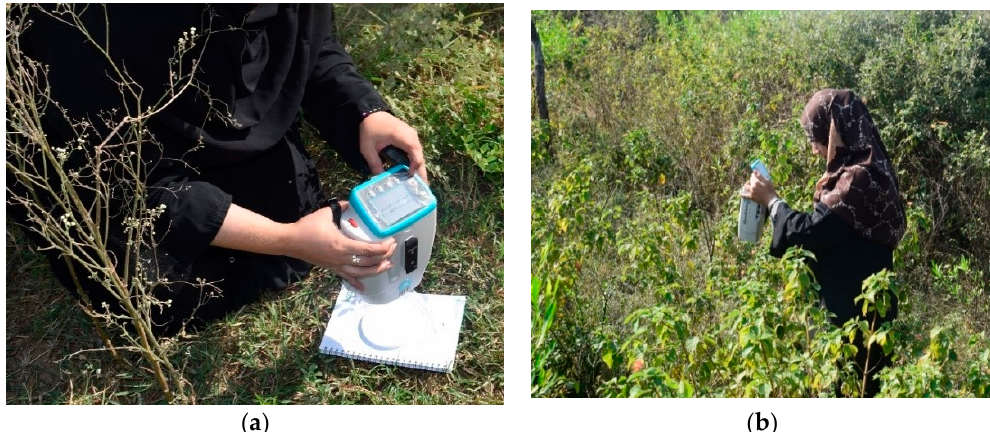
Figure 3. Data collection using the field spectroradiometer. Calibration using white reference panel avoiding shade ( a ); and taking the spectral reflectance of Lantana camara in the field ( b ).